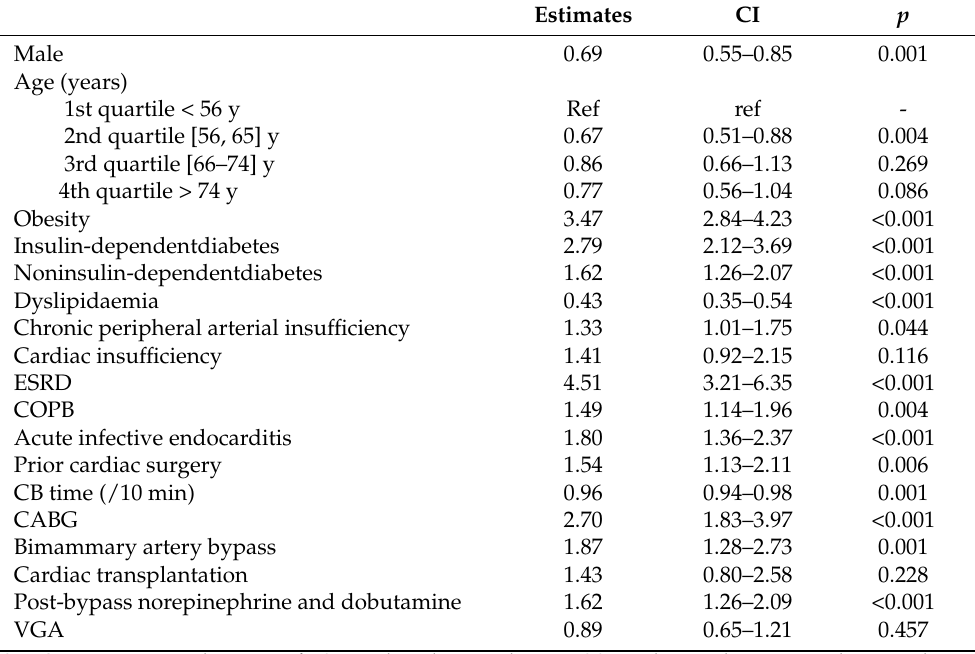
Table 4. Multivariate analysis of risk factors for SSI in a propensity score analysis.